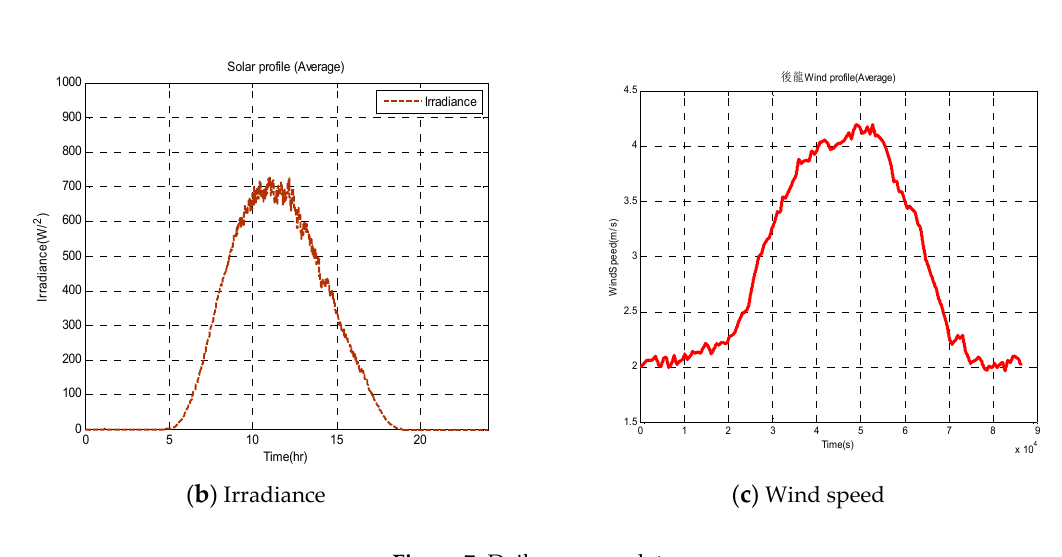
Figure 7. Daily average data.